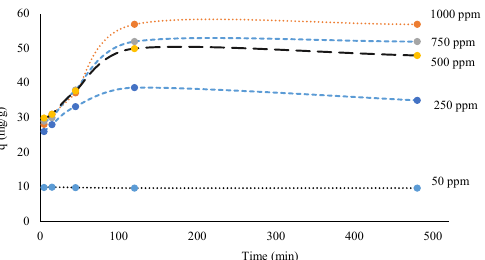
Fig. 5. Effect of initial ion concentration and contact time on the amount sorbet of Cd2+ ions onto natural zeolite.